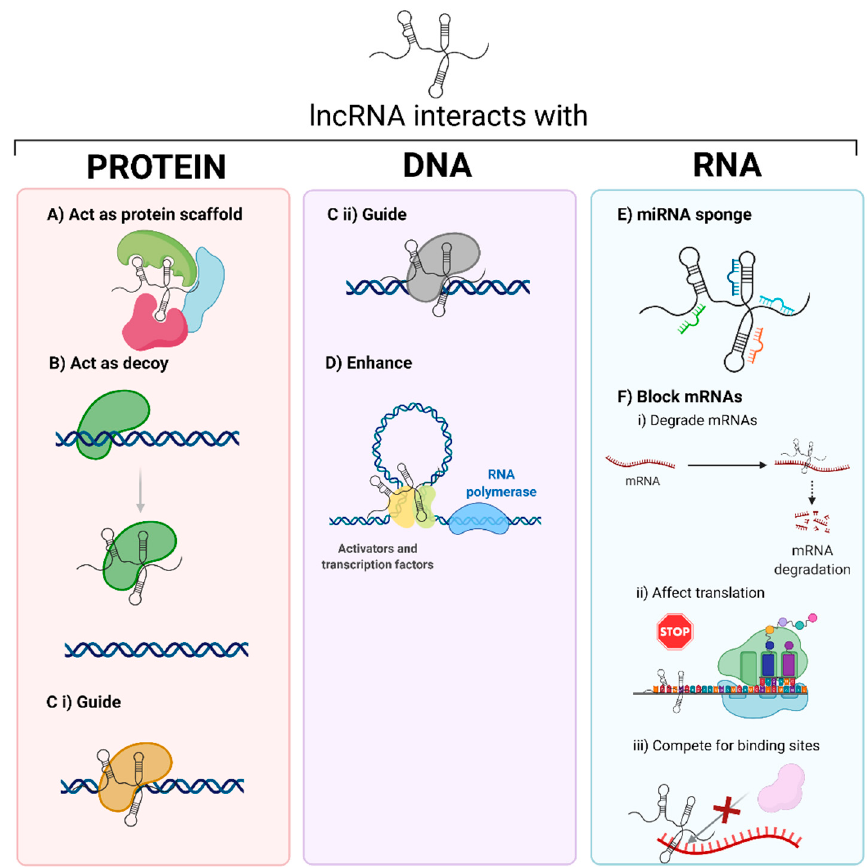
Figure 1. The interaction of lncRNAs with different biomolecules tunes their biological activity. LncRNAs can interact with proteins, DNA, or RNA, acting as ( A ) scaffolds of proteins, ( B ) decoys, preventing protein–oligonucleotide complex formation, ( C ) guides for ( i ) proteins or ( ii ) oligonu- cleotides, ( D ) enhancers, promoting transcription, ( E ) miRNAs sponges, or ( F ) mRNA inhibitors, blocking mRNA function due to ( i ) mRNA degradation, ( ii ) blocking translation, or ( iii ) competing for binding sites. Created with BioRender.com, accessed on 26 October Table 1. Biological processes and examples of lncRNAs.